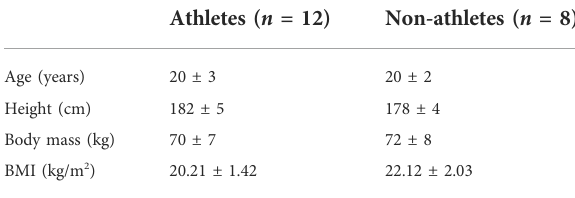
TABLE 1 Anthropometric data of